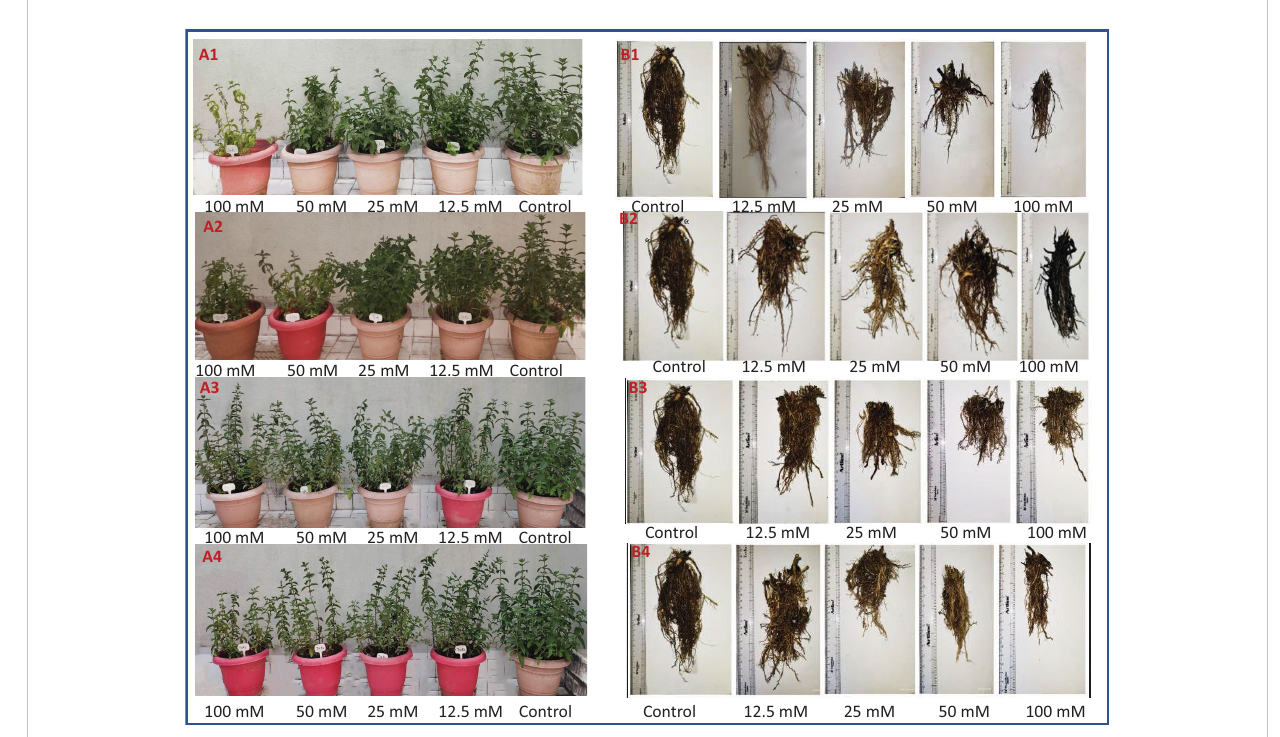
FIGURE 2 Morphology of M. longifolia plants ( A — shoot and B — root) treated with salts. (1) NaCl, (2) KCl, (3) MgSO 4 , and (4) CaCl 2